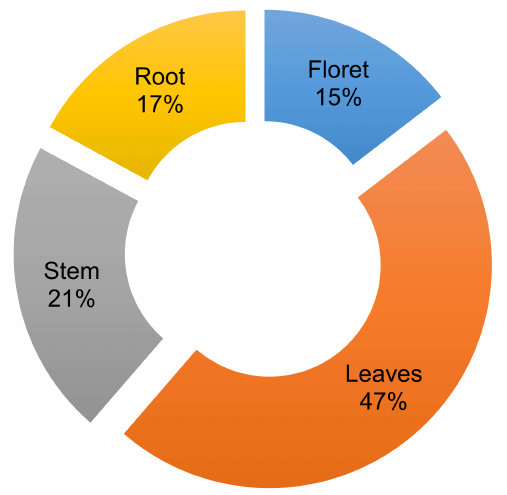
Broccoli (“Gypsy” cultivar, grown at the West Virginia Agronomy farm 2016 with conventional practice) individual tissue biomass (fresh weight) percentage to total biomass. The data collected from seven individual mature broccoli plants. Average of total biomass was 776 g per